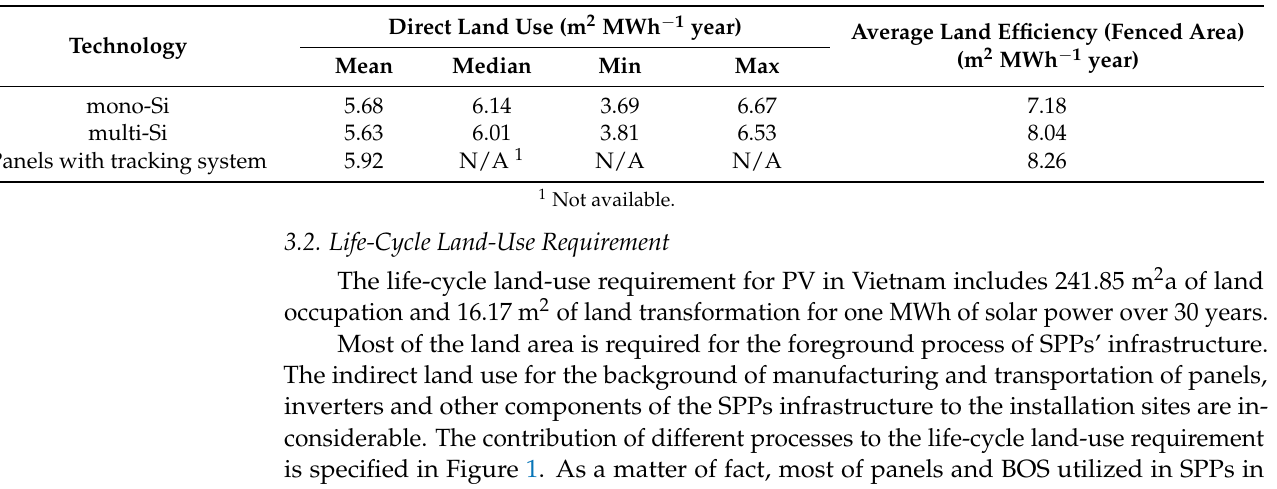
Table 3. Harmonized land use estimates of the solar PV plants (SPPs) in